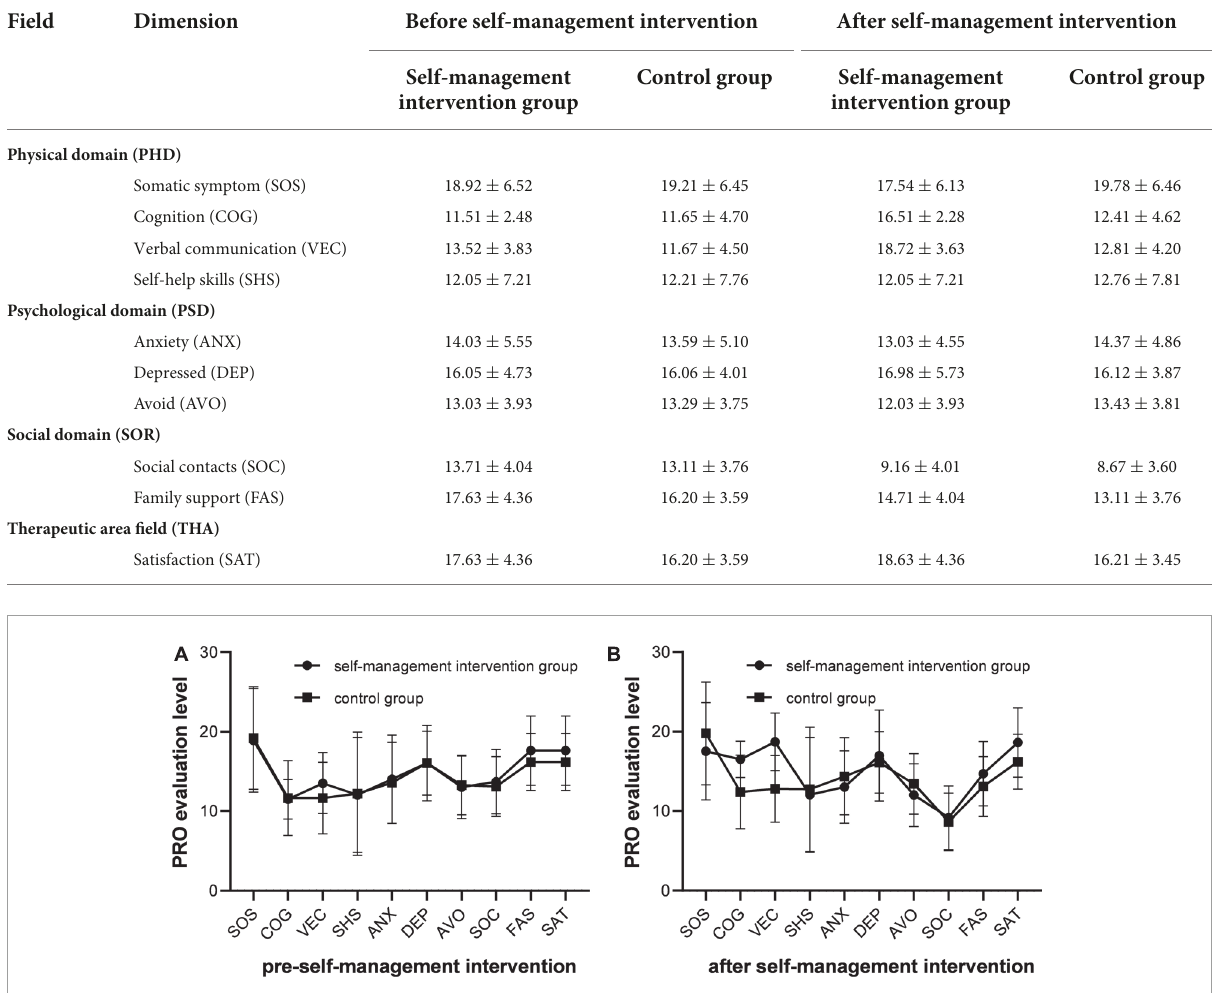
TABLE 3 Patient-reported outcome questionnaire results of stroke patients in the rehabilitation period (x ± s).